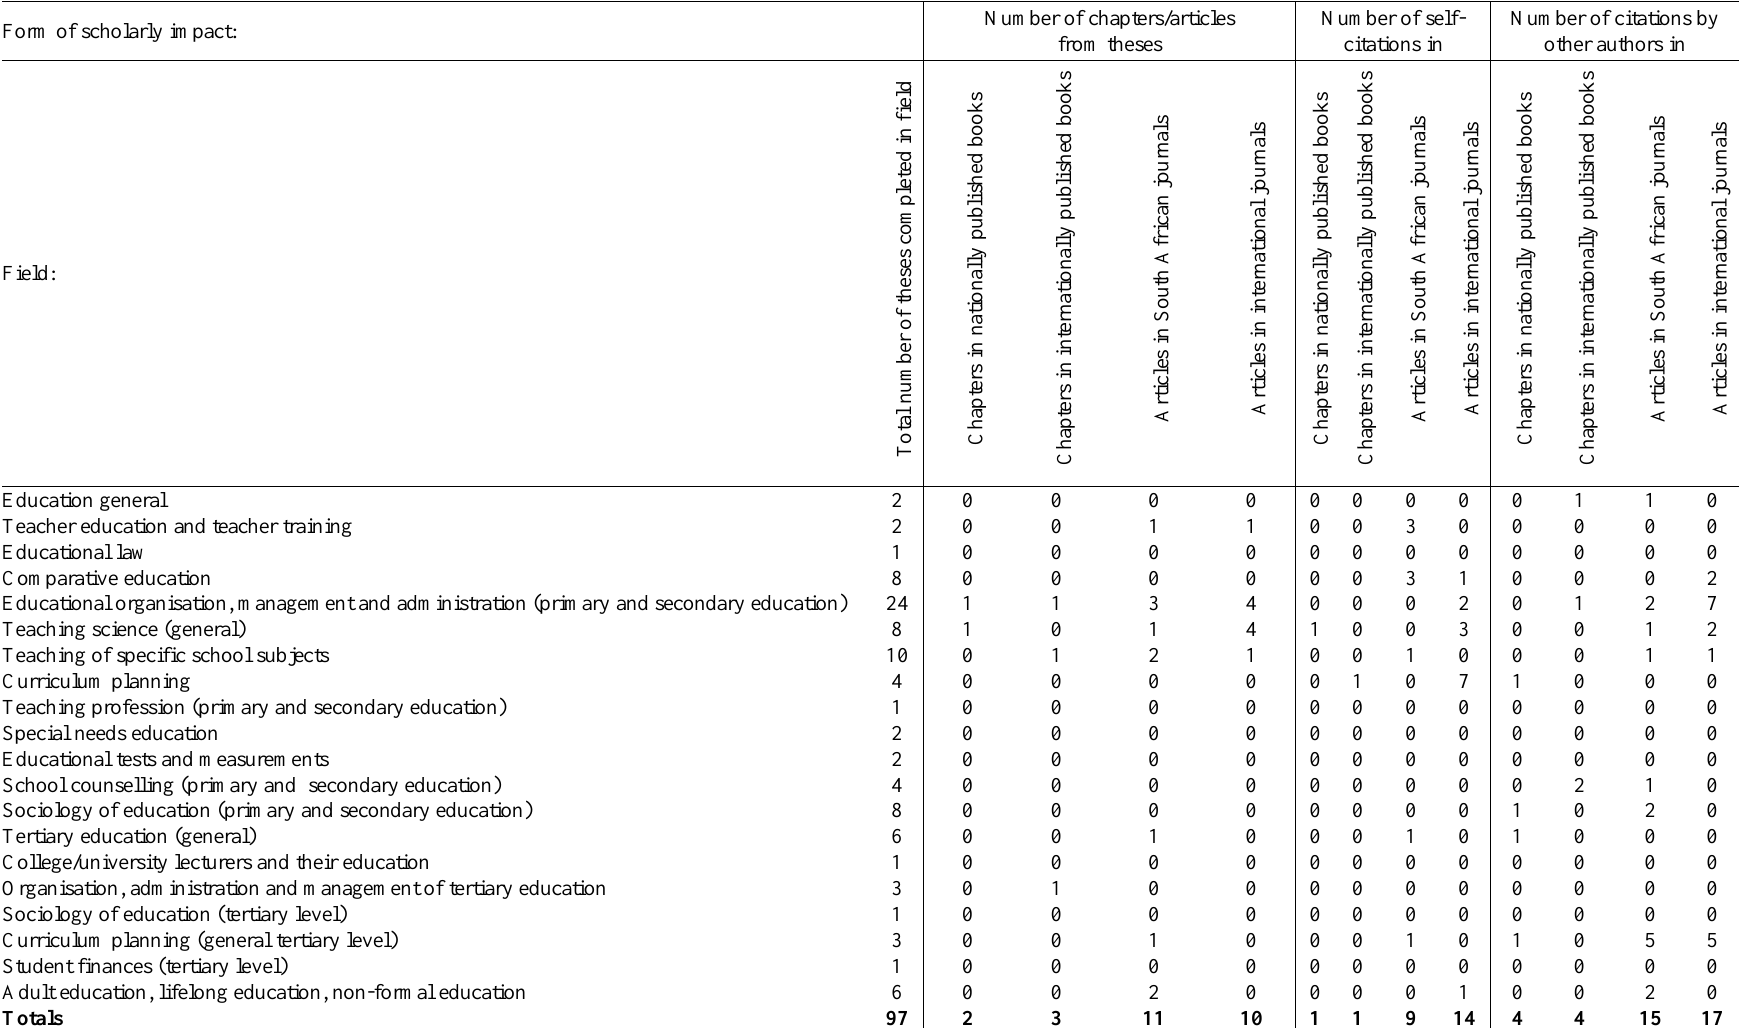
Table 9 Distribution of the various forms of scholarly impact with respect to the various fields of educational research in which the theses were